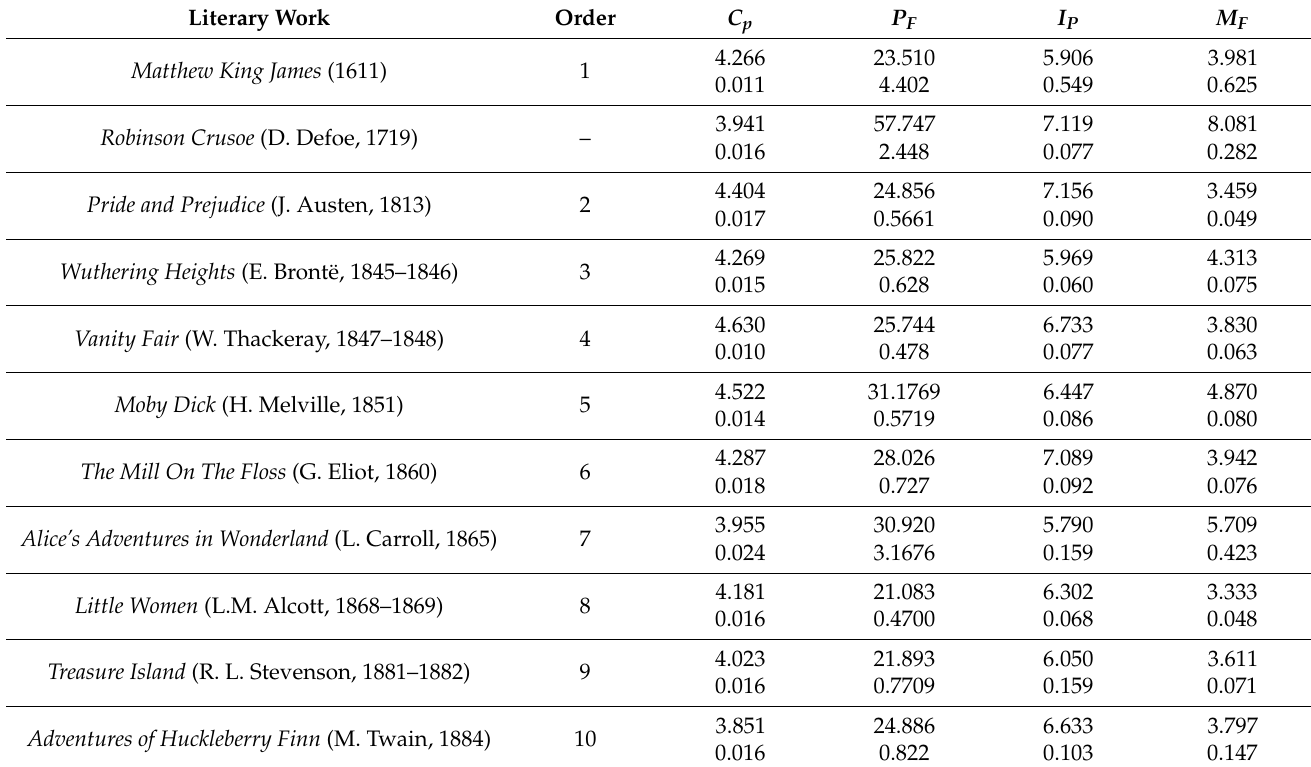
Table 3. English literature. Literary works are ordered according to publication years. Deep language parameters C P , P F , I P , M F , with standard deviation reported in the second line. The order number is useful to identify the single literary works in Figure